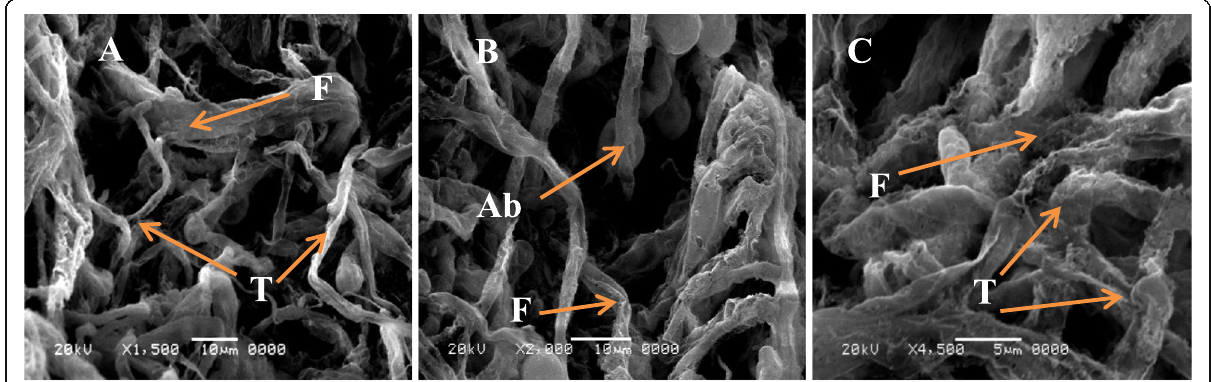
Fig. 5 Scanning electron microscopy observations of the mycoparasistic nature of T. atroviride on F. oxysporum. A Growing of Trichoderma hyphae (T) parallel to Fusarium hyphae (F) & coling of (T) around (F); B Sticking of of Trichoderma hyphae (T) with Fusarium hyphae (F) and formed of appressoria like structures, “ Ab ” ; C Finally the Fusarium wall lysed